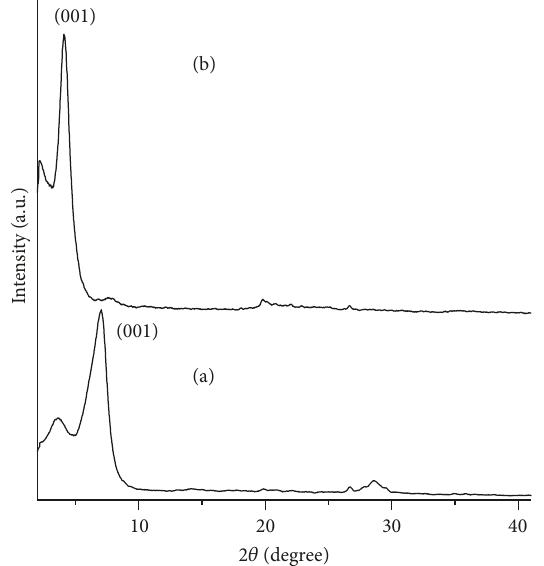
Figure 6: XRD patterns for bentonite (a) and organobentonite